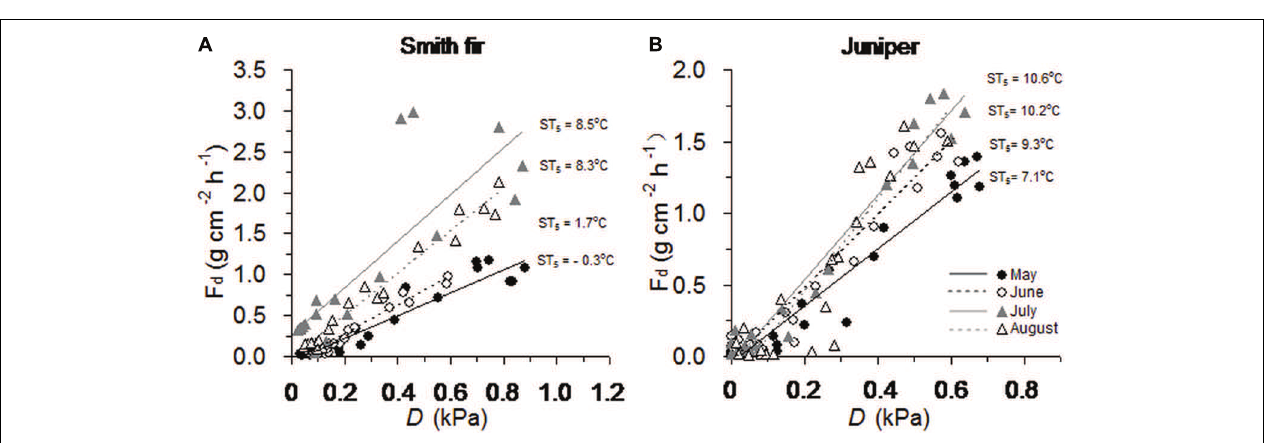
F-values and P-values of ANCOVA were shown. Pair-wise comparisons were made when the results of ANCOVA were significant. Different letters within a row indicate significant differences in slopes of hourly sap flow density vs. D among different growing-season months at P < 0.05.